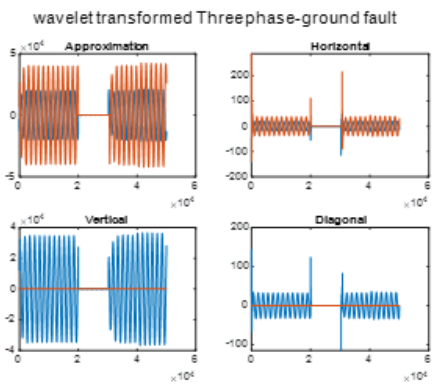
Figure 17. Waveforms of IMF 3 and instantaneous amplitude of phase